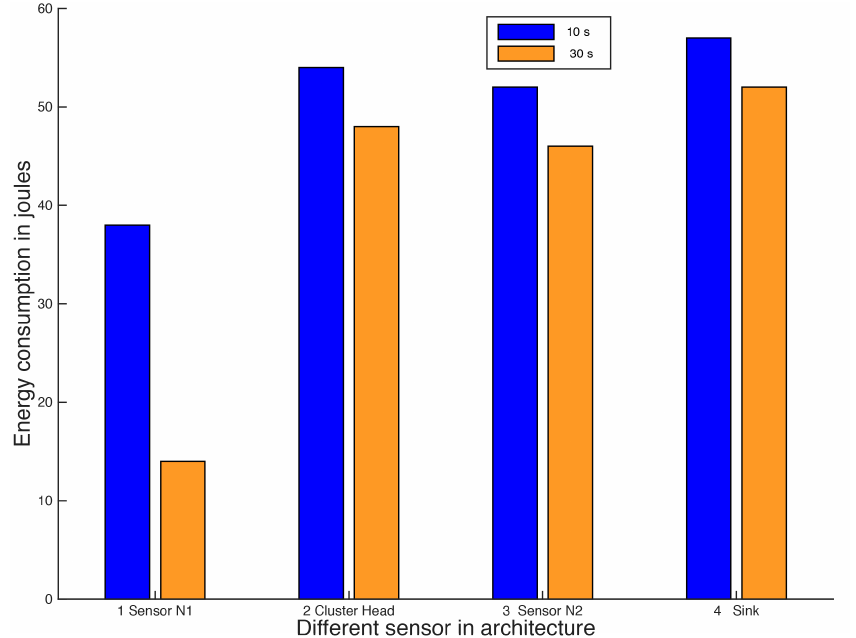
Figure 15. Average energy consumption of each group of sensors in the